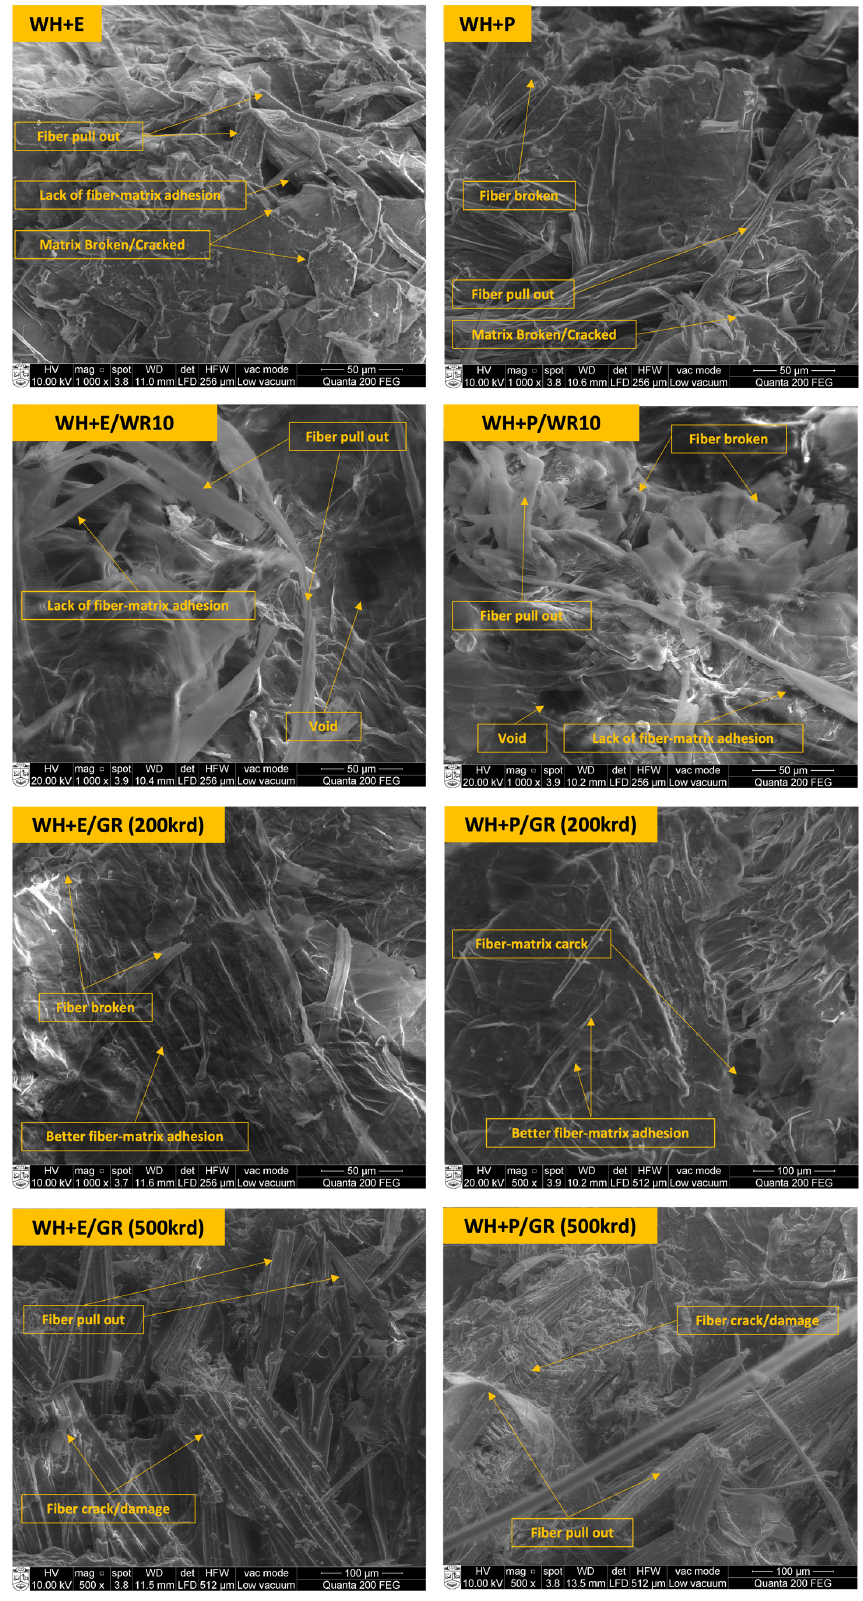
Figure 8. SEM micrographs on the tensile fractures of standard water hyacinth (WH) composites (WH + E and WH + P), water-repellent-treated WH composites (WH + E/WR and WH + P/WR) and gamma-irradiated WH composites (WH + E/GR and WH + P/WR).